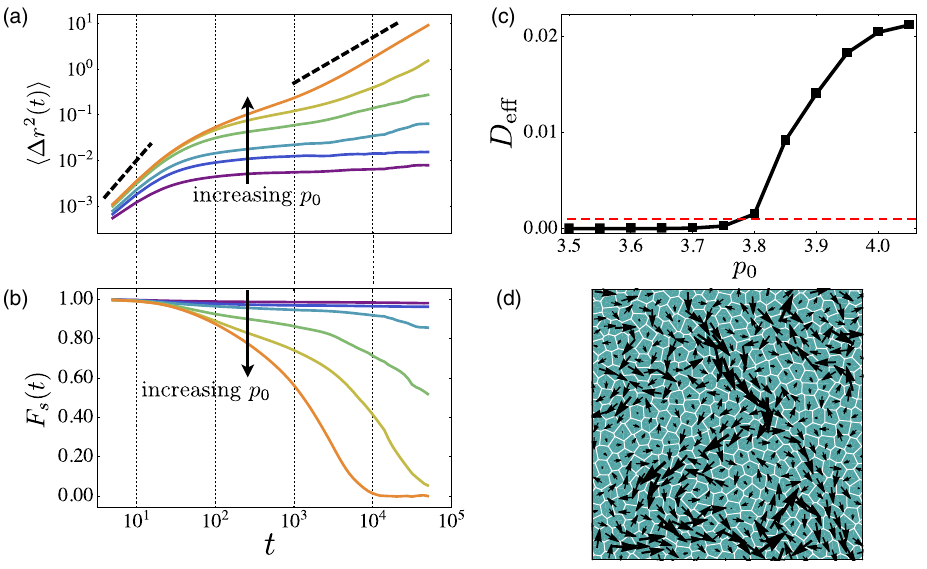
1 and v 0 . 1 and various values of FIG. 1. Analysis of glassy behavior. (a) The mean-squared displacement of cell centers for D 0 ¼ r ¼ p 0 (bottom to top: p 0 ¼ 3 . 5 , 3.65, 3.7, 3.75, 3.8, 3.85) show the onset of dynamical arrest as p 0 is changed indicating a glass transition. The dashed lines indicate a slope of 2 (ballistic) and 1 (diffusive) on a log-log plot. (b) The self-intermediate scattering function at the same values of p 0 shown in (a) shows the emergence of caging behavior at the glass transition. (c) The effective self-diffusivity as a function of p 0 at v 0 ¼ 0 . 1 . At the glass transition D becomes nonzero. (d) The cell displacement map in the SPV model for a fluid eff 1 ) over a time window t ¼ 10 4 corresponding to the structural state very close to the glass transition ( p 0 ¼ 3 . 8 , v 0 ¼ 0 . 1 , and D r ¼ t Þ ≈ 1 = 2 relaxation at which F s ð